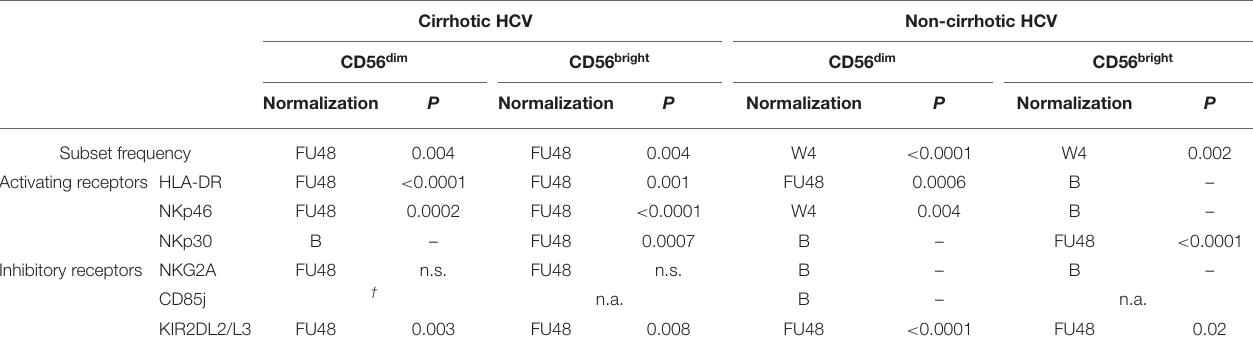
P-values correspond to the mixed models for repeated measurement analysis between baseline and the normalization time point. n.a., not applicable; n.s., not significant; † , not normalized at FU48; B, baseline (before therapy); W4, week 4 during therapy; FU12, 12 weeks after the end of therapy; FU48, 48 weeks after the end of therapy; NK, natural killer; HCV, hepatitis C